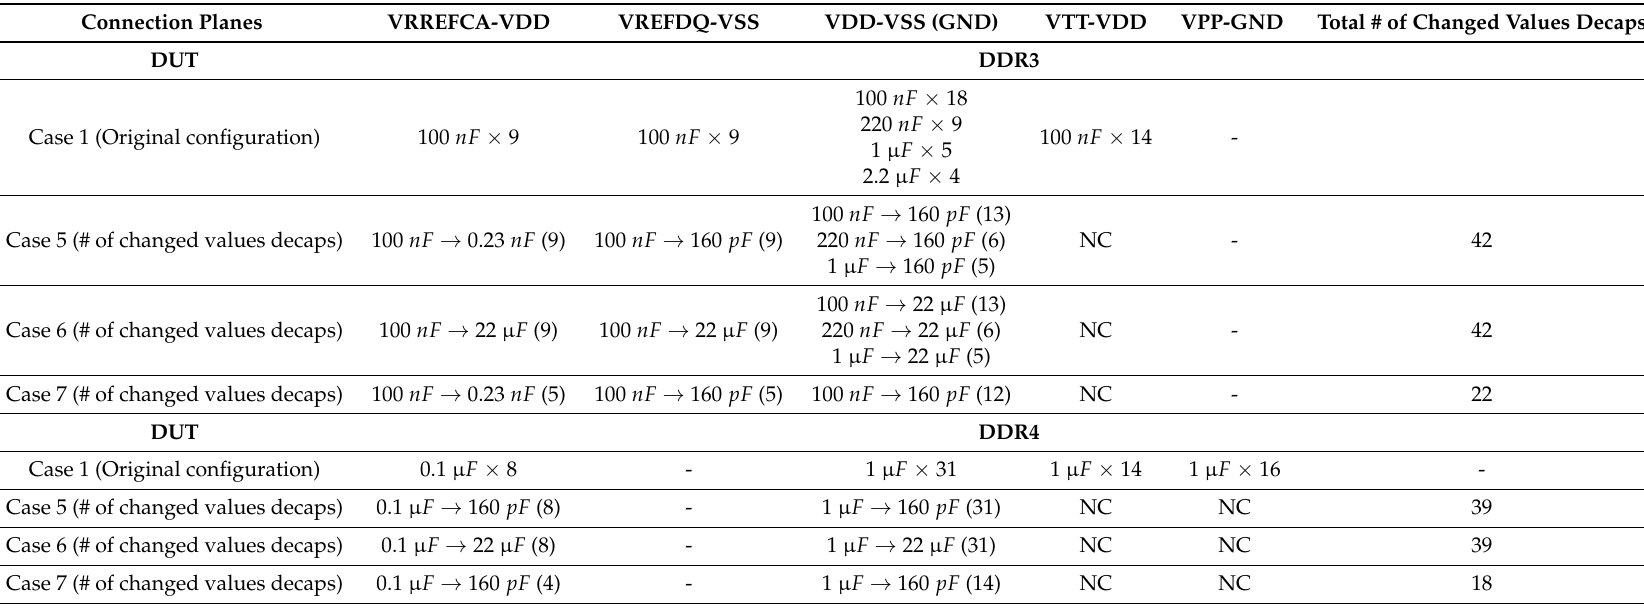
Table 9. DOE cases for the analysis of coupled ESD noise with the change in values of installed decaps on memory modules (NC: no change). Connection